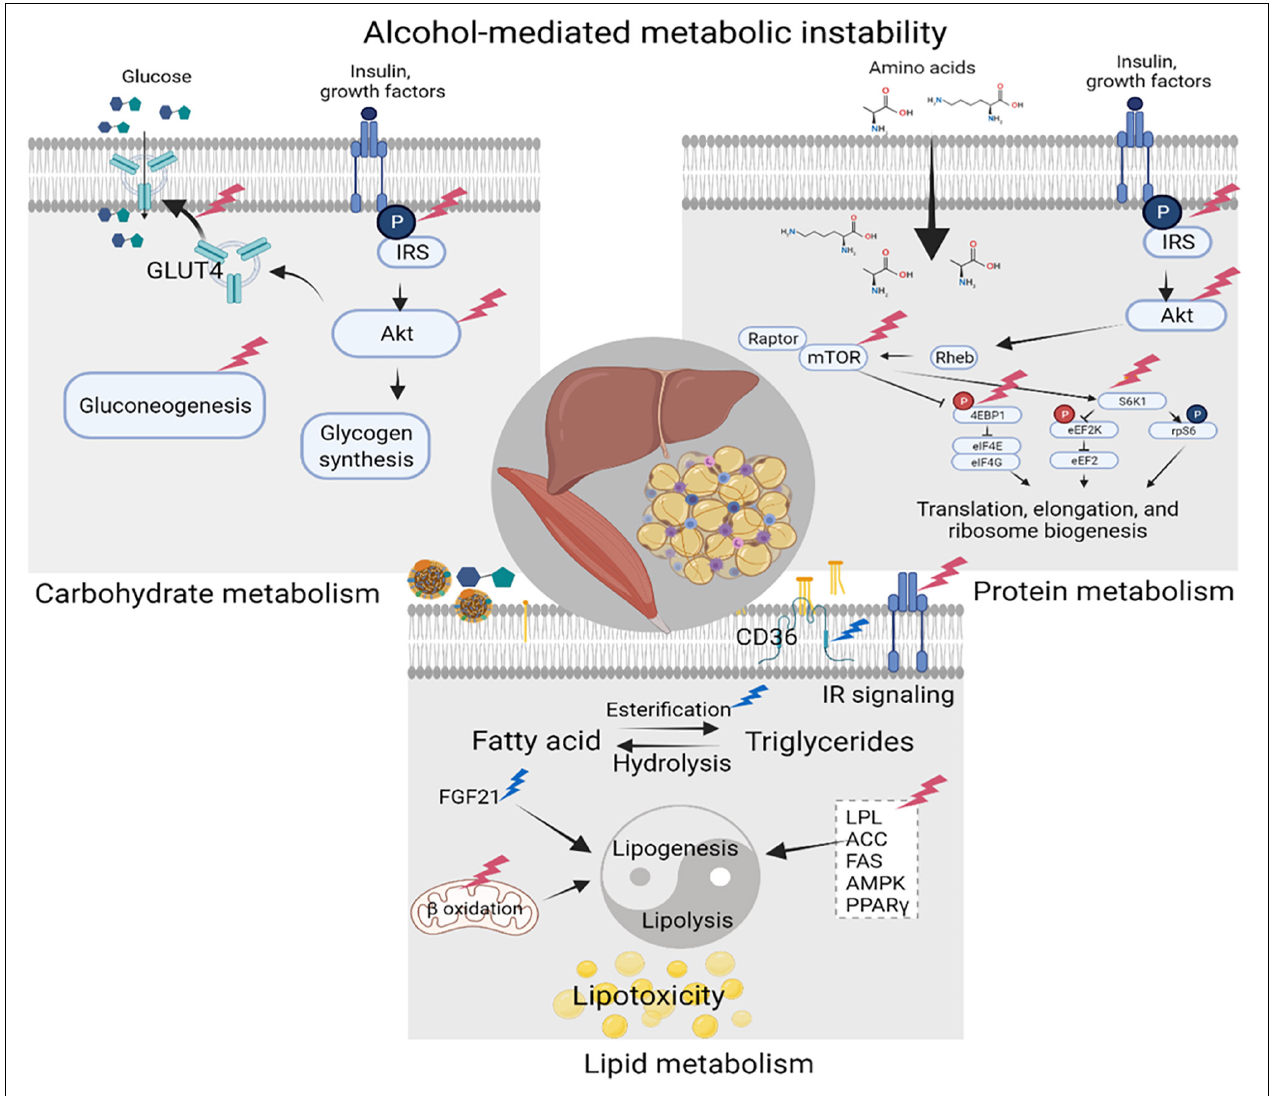
FIGURE 3 | Alcohol-mediated metabolic instability. Alcohol produces carbohydrate, lipid, and protein metabolic dysregulation directly, and indirectly through the generation of its metabolites. Principal target organs include the liver, adipose tissue, and skeletal muscle (SKM). Alcohol-associated alterations in synthesis and breakdown of carbohydrates, lipids, and proteins, result in metabolic instability and increase the risk for cardiometabolic syndrome (CMS). Created with